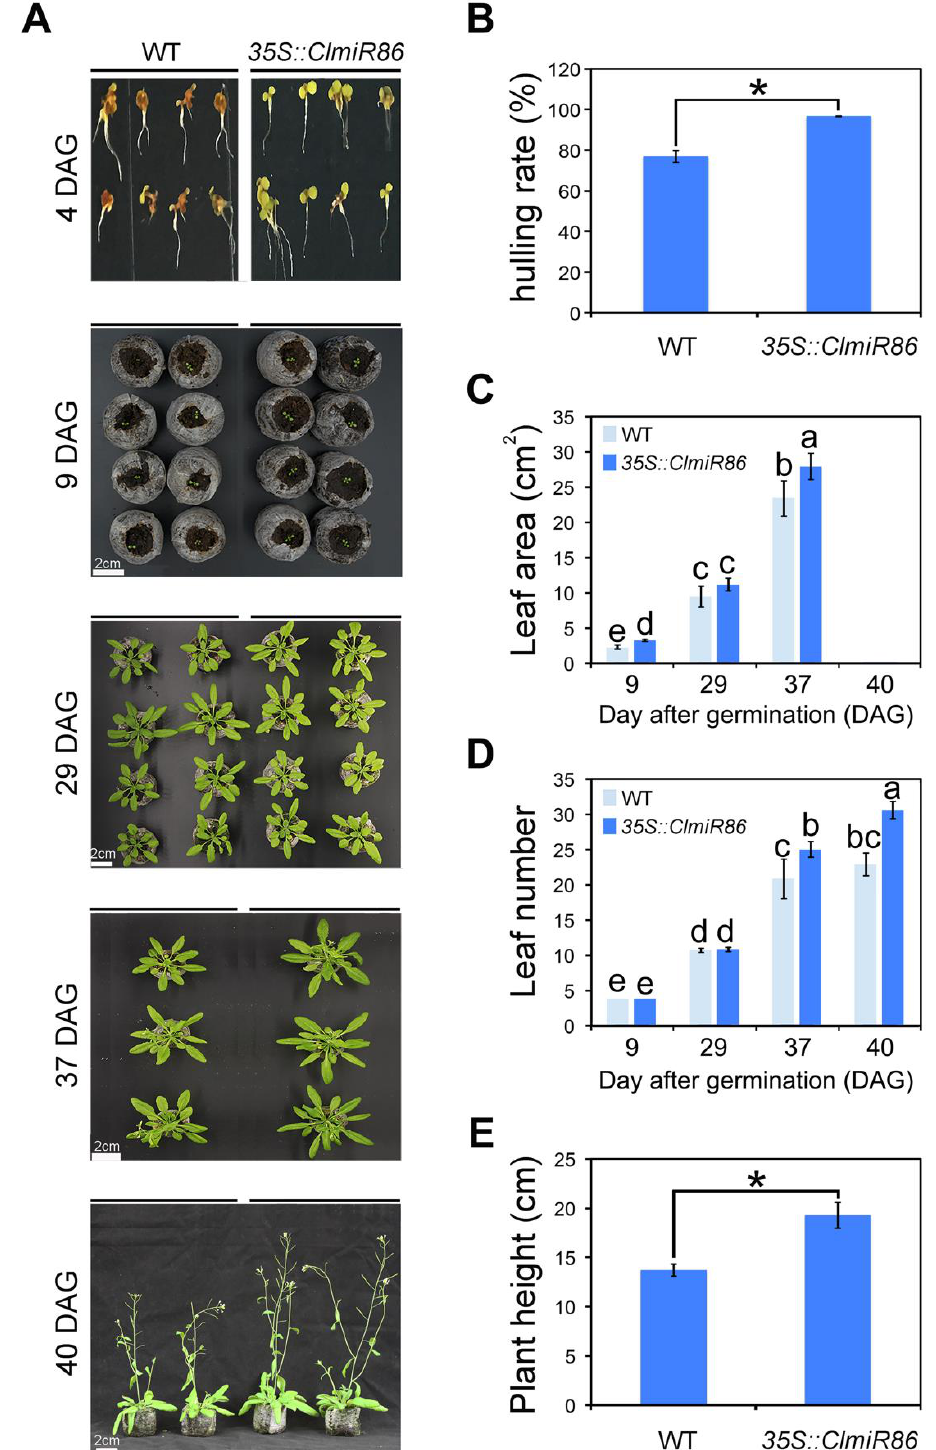
Figure 7 . Ectopic expression of ClmiR86 enhanced plant growth under normal conditions. ( A ) Phenotype of wild type (WT) and 35S::miR86 seedlings at 4, 9, 29, 37, and 40 day-after-germination (DAG). ( B ) Hulling rate of Arabidopsis seeds at 4 DAG age. ( C ) Average leaf area of Arabidopsis seedlings at different Age. ( D ) Average leaf number of Arabidopsis seedlings at different DAG age. ( E ) Plant/inflorescence height of Arabidopsis seedlings at 40 DAG age. Asterisk (*) or different lower- case letters indicates significant difference in hulling rate, leaf area and number, or plant height ( p < 0.05, one- way ANOVA and then Tukey’s test for multiple comparisons). Values are means ± SD ( n = 10).